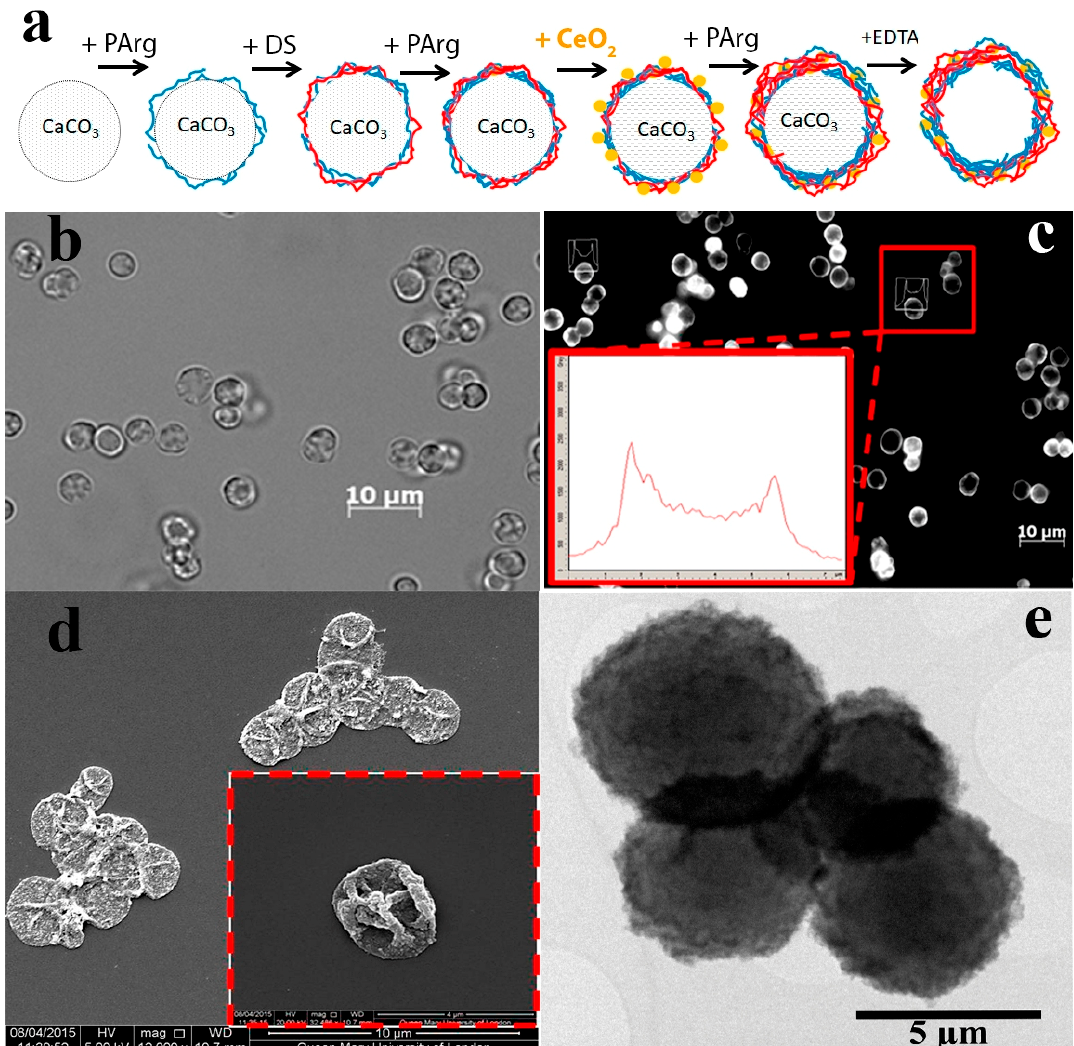
Figure 2. The scheme of biodegradable nanoceria-loaded polyelectrolyte microcapsules synthesis ( a ), laser confocal scanning microscopy in a bright field mode ( b ), laser scanning confocal microscopy in a fluorescence mode (inset - microcapsule fluorescence profile) ( c ), SEM ( d ), TEM ( e ) of nanoceria-loaded polyelectrolyte microcapsules.